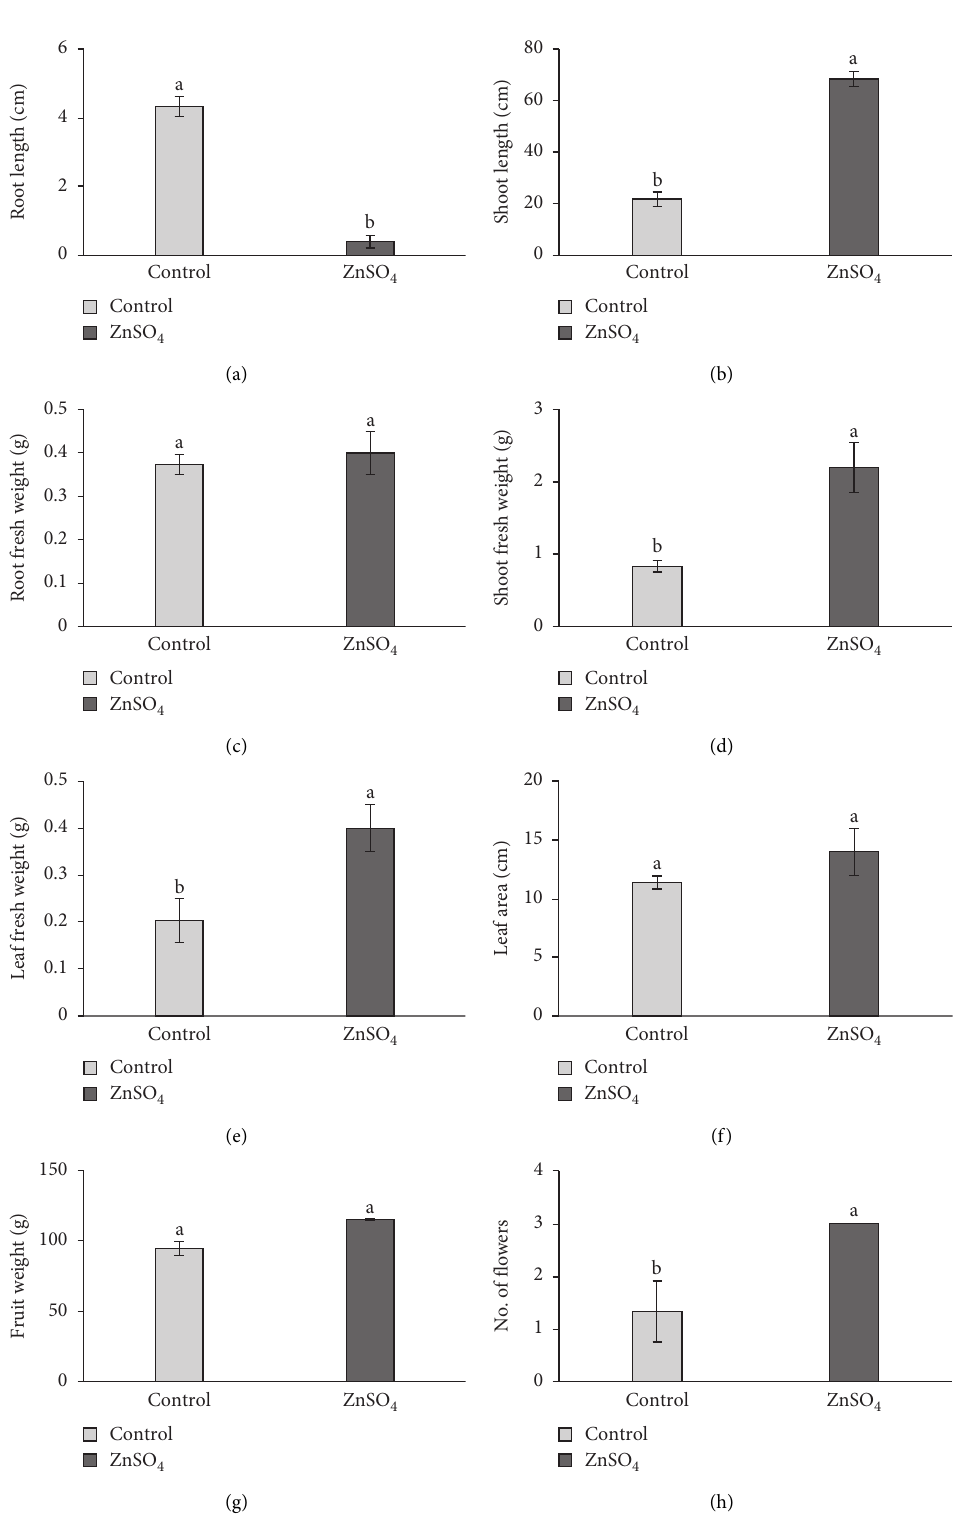
Figure 2: Effect of zinc sulfate seeds priming upon morphological parameters of (M) charantia. (a) Root length, (b) shoot length, (c) root fresh weight, (d) shoot fresh weight, (e) leaf fresh weight, (f) leaf area, (g) fruit weight, (h) no. of